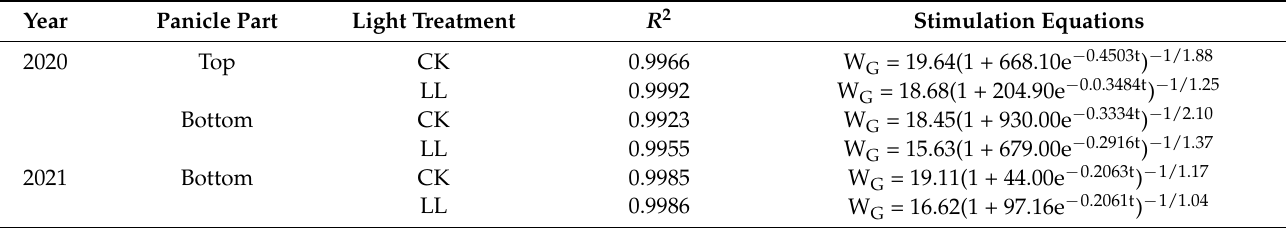
Table 2. Stimulation equations of grain filling of different panicle parts under low light